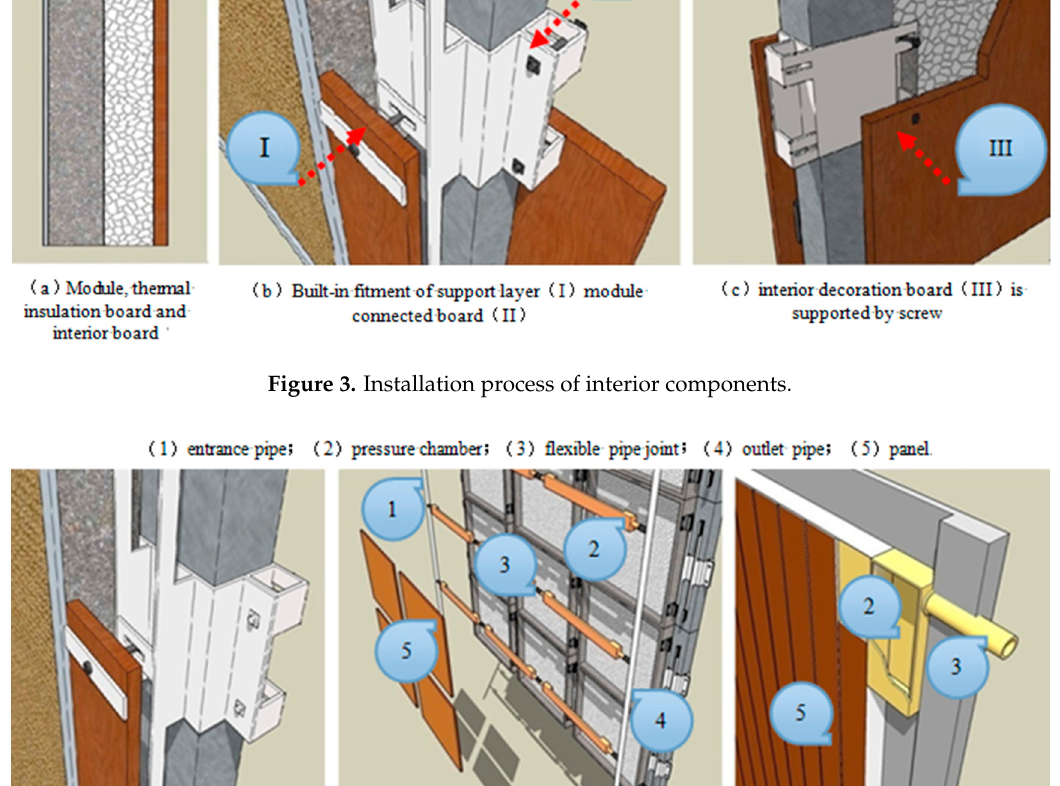
Figure 3. Installation process of interior components.